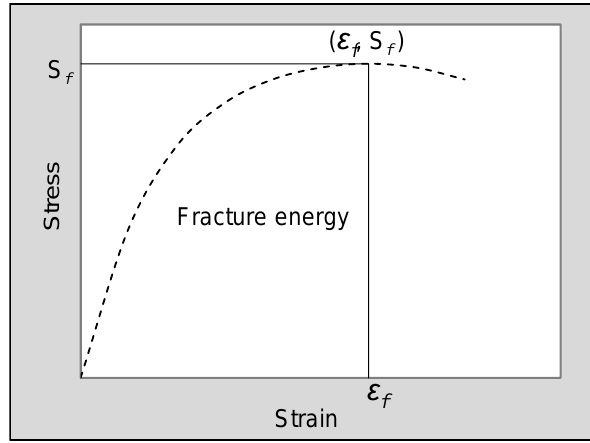
Figure 3. Determination mechanism of fracture energy.